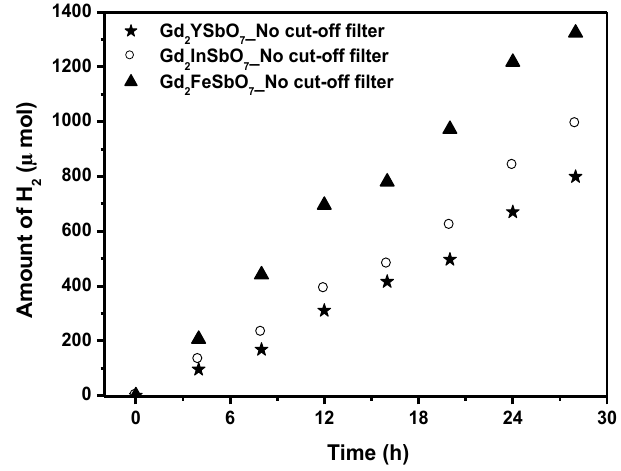
Figure 6. Photocatalytic H 2 evolution from aqueous methanol solution with Gd 2 FeSbO 7